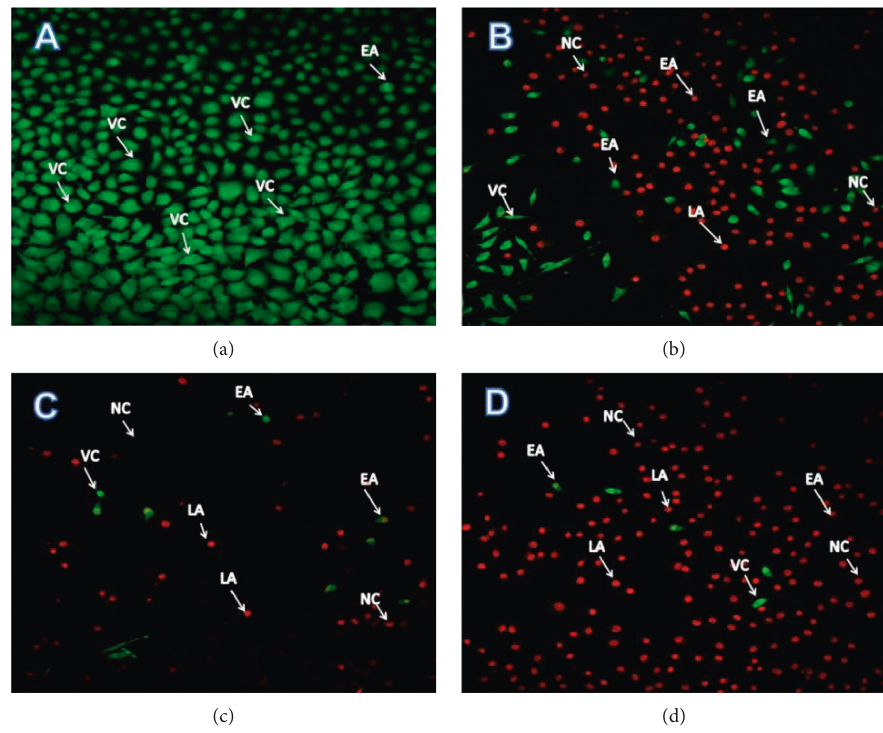
Figure 10: Analysis of apoptosis by AO/EtBr staining method. (a) Image of untreated A549 cell line; (b) image of the 50 μ g/mL of SP- ZnONPs-treated A549cell line; (c) image of the 60 μ g/mL of SP-ZnONPs-treated A549 cell line; (d) image of the 70 μ g/mL of SP-ZnONPs- treated A549cell line. VC: viable cells; EA: early apoptotic cells; LA: late apoptotic cells; NC: necrotic cells.